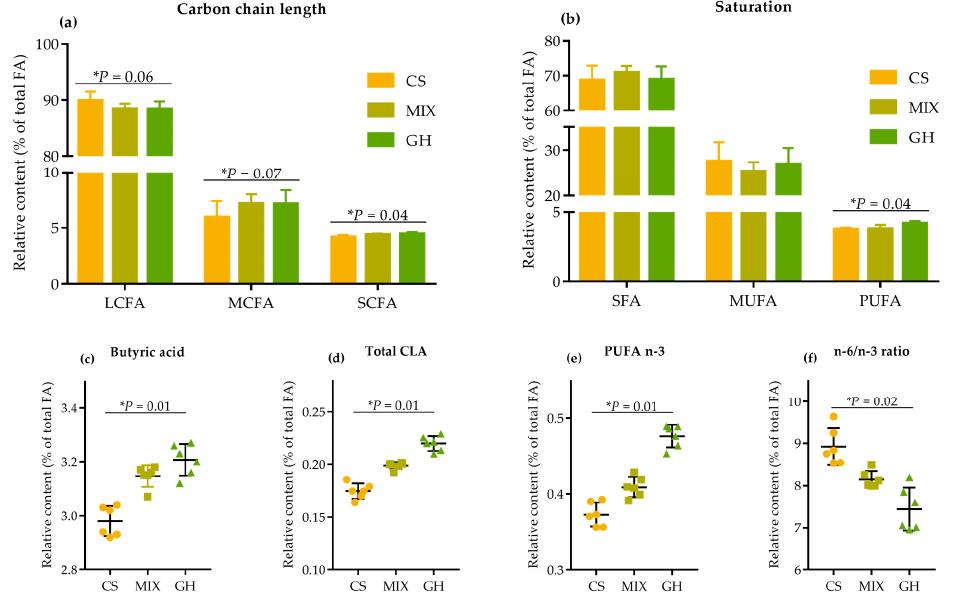
Figure 3. Effects of different forage sources on relative contents of ( a ) carbon chain length of fatty acids, ( b ) saturation of fatty acids, ( c ) butyric acids (C4:0), ( d ) total CLA, ( e ) n ‐ 3 PUFA, and ( f ) OCFA in milk. SCFA = short ‐ chain fatty acid: C4:0 + C6:0; MCFA = medium ‐ chain fatty acid: C10:0 + C12:0; LCFA = long ‐ chain fatty acid: carbon chain > 12 (C13:0 to C24:1); SFA = saturated fatty acid: C10:0 +